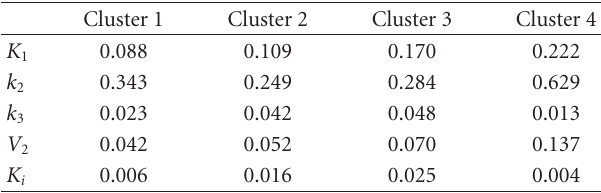
Table 1: The parameters of every cluster with NLS